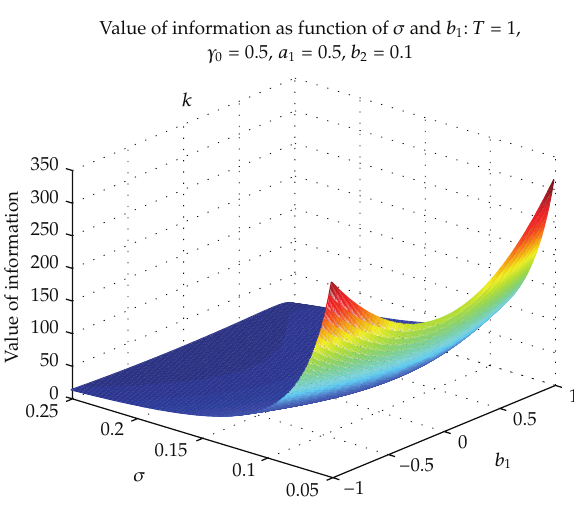
Figure 2: V as a function of σ and b 1 .